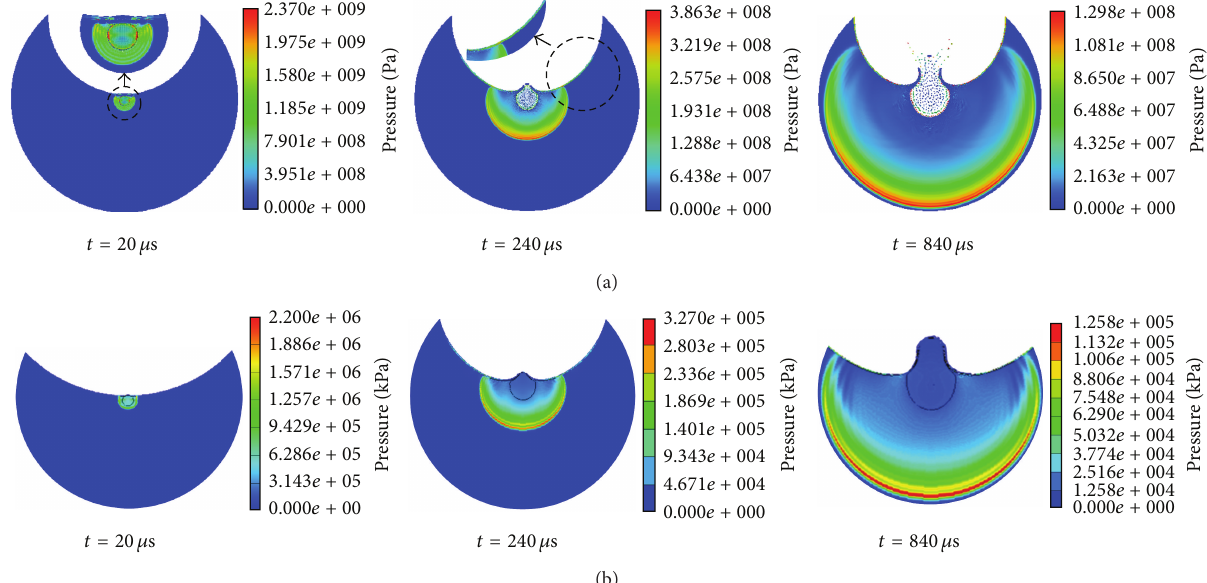
Figure 3: Pressure nephograms of different methods: (a) SPH method, (b)